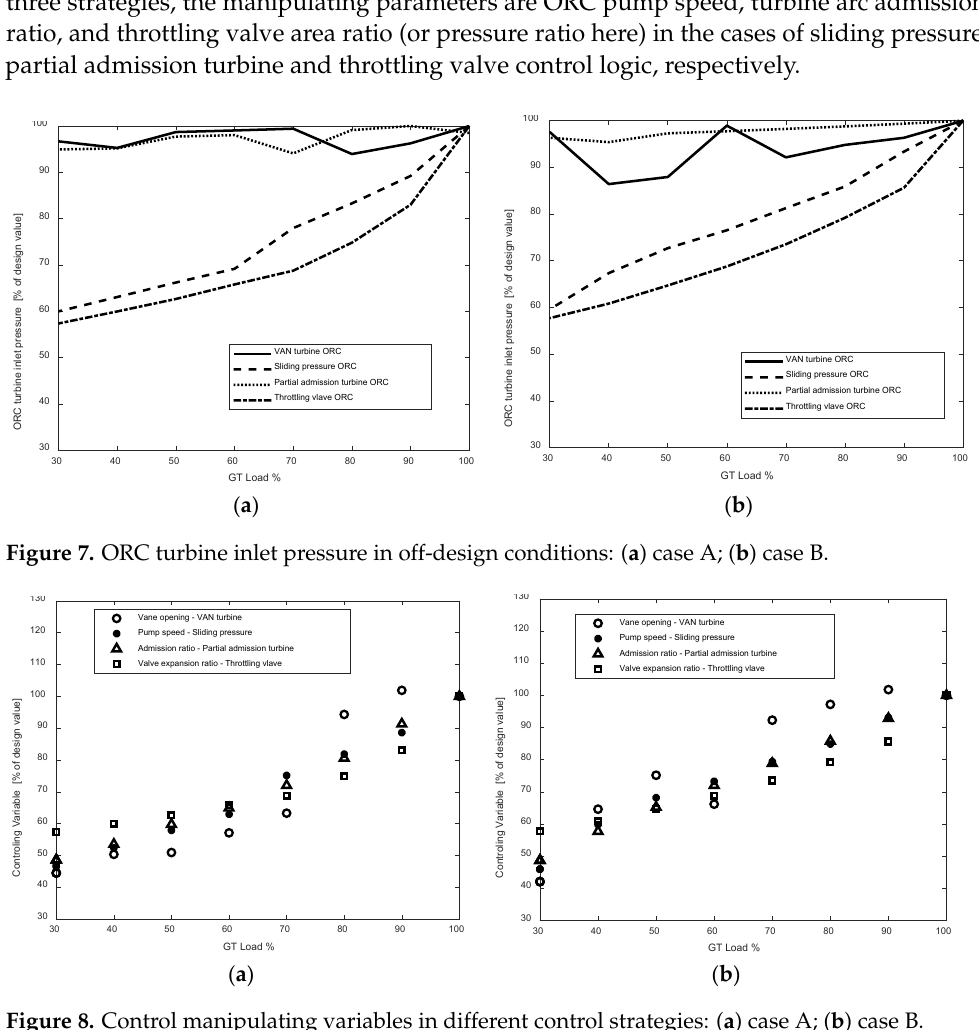
( b ) Figure 9. Economizer off-design characteristics: ( a ) heat transfer coefficient; ( b ) pressure loss.